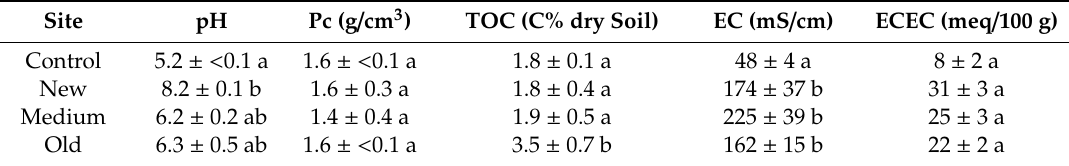
Table 1. Soil characteristics for roadside soils in western Melbourne, Australia, on Newer Volcanic parent material; values are mean ± standard error (n = 3). Soils were collected from new (N = 1.5–5 years), medium (M = 5–10 years) and old (O ≥ 15 years) roads. Numbers in a column with the same letter are not significantly di ff erent ( p > 0.05).